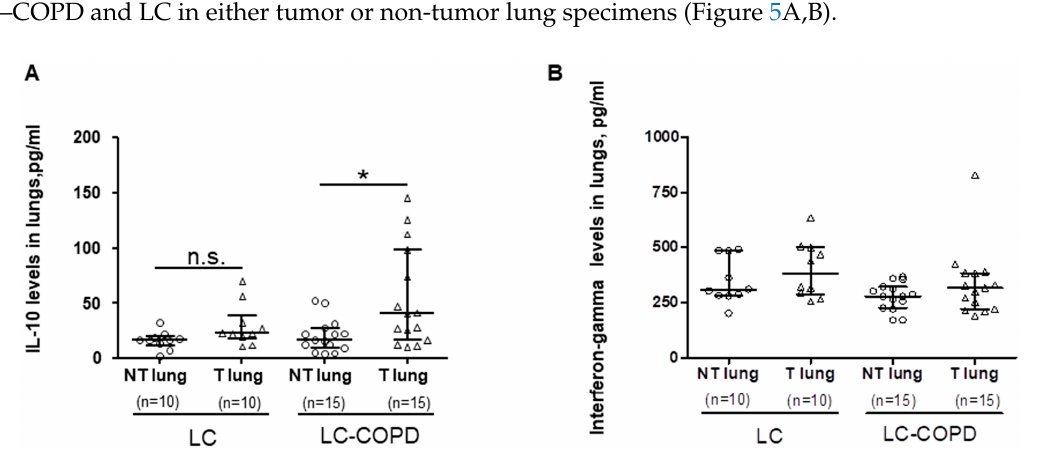
Figure 5. ( A ) Mean values and SD of number IL-10 levels by ELISA in LC and LC–COPD patients, respectively. ( B ) Median and interquartile ranges between 75th and 25th percentiles of number of interferon-gamma levels by ELISA in LC and LC–COPD patients, respectively. Comparisons were made between the non-tumor (NT) and tumor (T) samples and the LC and LC–COPD groups. For technical reasons, the number of patients in each group or type of samples (tumor and non-tumor) may di ff er. Statistical significance: *, p ≤ 0.5 between tumor (T) and non-tumor (NT) lungs in LC–COPD patients. Definition of abbreviations: LC, lung cancer; COPD, chronic obstructive pulmonary disease; IL, interleukin; IFN, interferon. ELISA, enzyme linked immunosorbent assay.